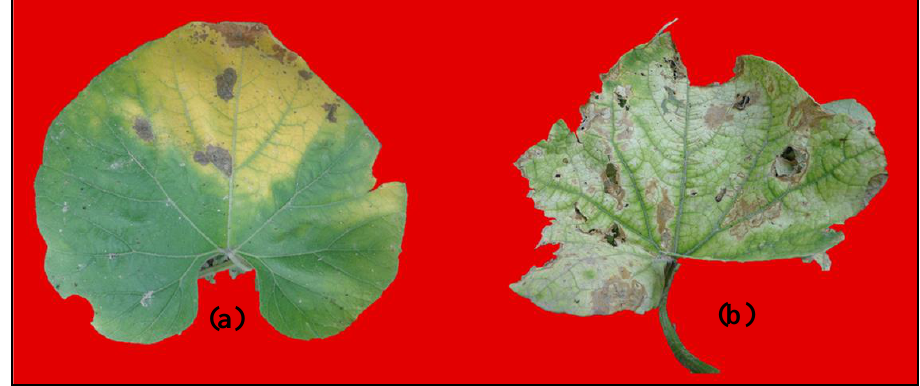
Figure 5. Gas injury caused by SO 2 exposure at ( a ) 50 ppb and ( b ) 75 ppb.